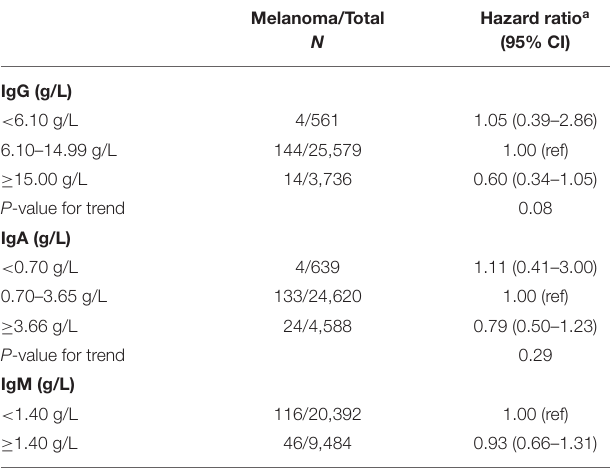
(CI) using Cox proportional hazards model. Melanoma/Total